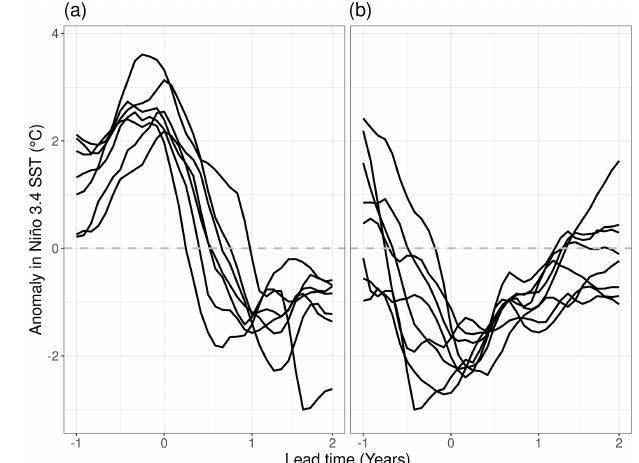
Figure 1. Three-month running mean SST anomaly in the Niño 3.4 region of (a) seven El Niño and (b) eight La Niña simulations. Simulations are initialized at lead time 0 and run for 24 months. Lines show the Niño 3.4 SST of the control simulation.